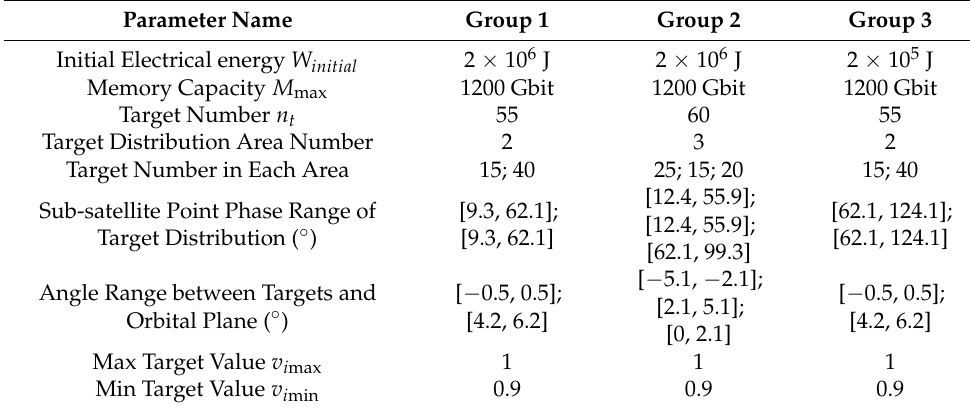
Table 3. Condition